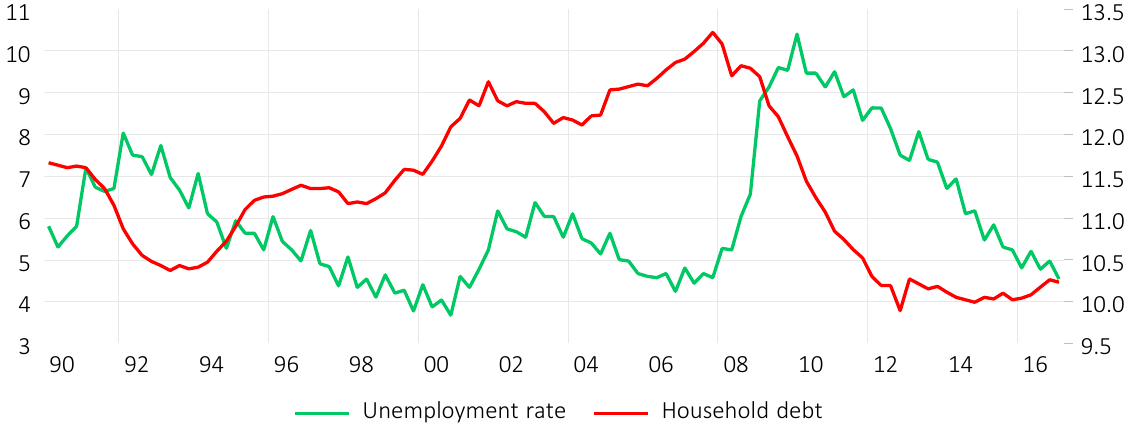
Figure 3. US unemployment rate vs US household